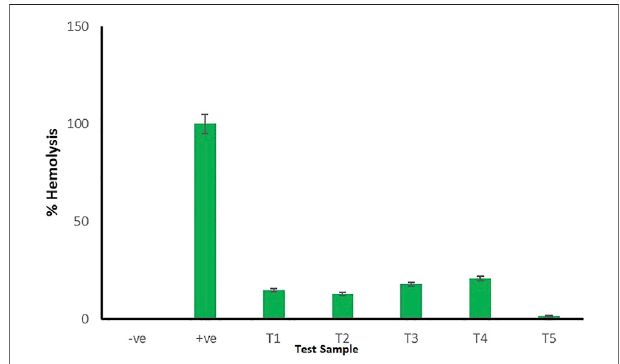
FIGURE 8 | (A) First-order degradation kinetics plot for CMN mucoadhesive tablet formulation (M14) (B) Arrhenius plot for CMN colon-targeted tablet (M14).